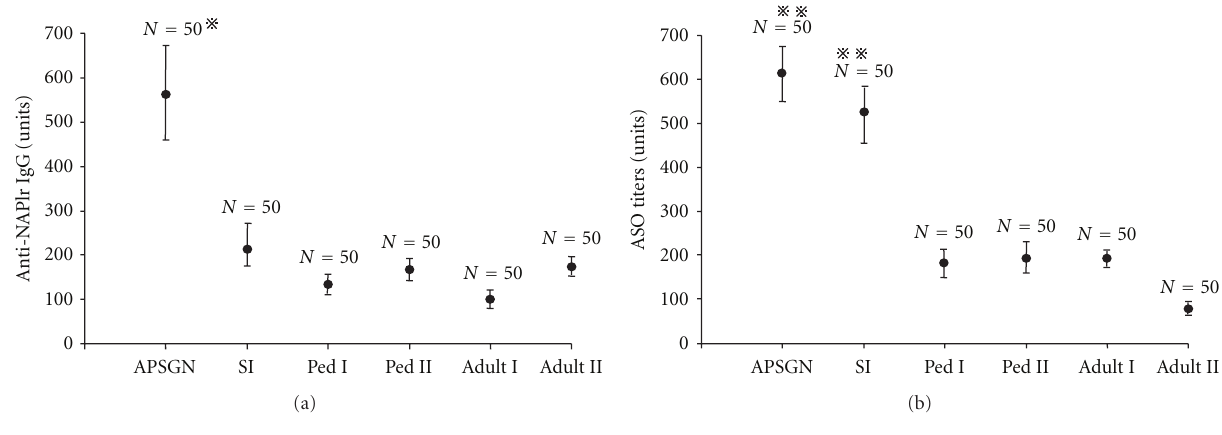
Figure 1: (a) The results of Western blotting assay for anti-NAPlr antibody titers in patients with acute poststreptococcal glomerulonephritis (APSGN), patients with a streptococcal infection (SI) without renal involvement, pediatric patients without renal disease, and normal healthy adults (see Table 1 for ages of subjects in each group). Values are means ± SEM. ∗ P < 0 . 05 for APSGN versus SI, pediatrics, and normal adults by t test. (b) ASO titers for the same groups of patients. The titers in the APSGN and SI groups are significantly higher than those in the normal adults and the pediatric patients without renal disease. Values are means ± SEM. ∗∗ P < 0 . 001 for APSGN or SI versus those in other groups by t test.